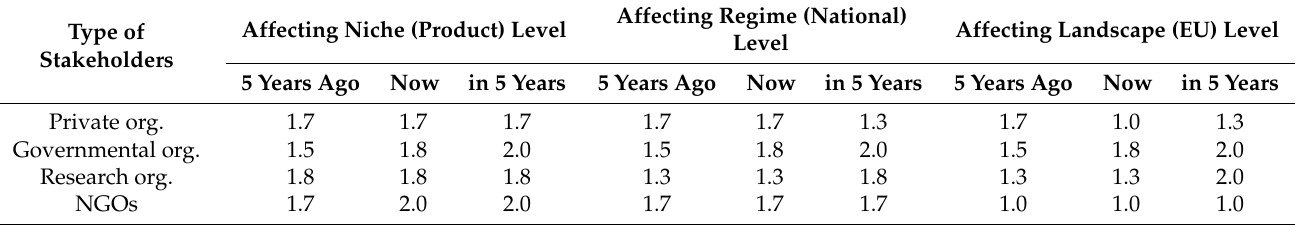
Table 5. Stakeholder’s level of influence for biogas production from manure and agro wastes in